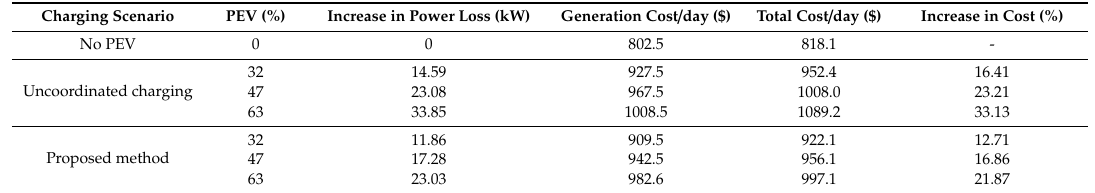
Table 3. The daily cost of energy generation.